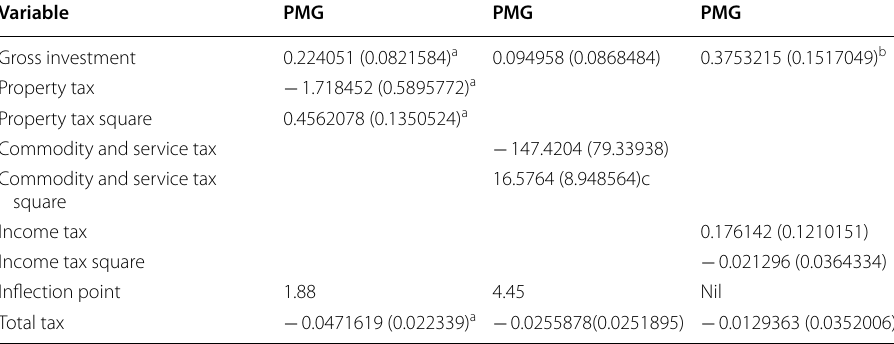
a ,b, c Statistically significant at 1%, 5% and 10% level Parenthesis values represent standard errors